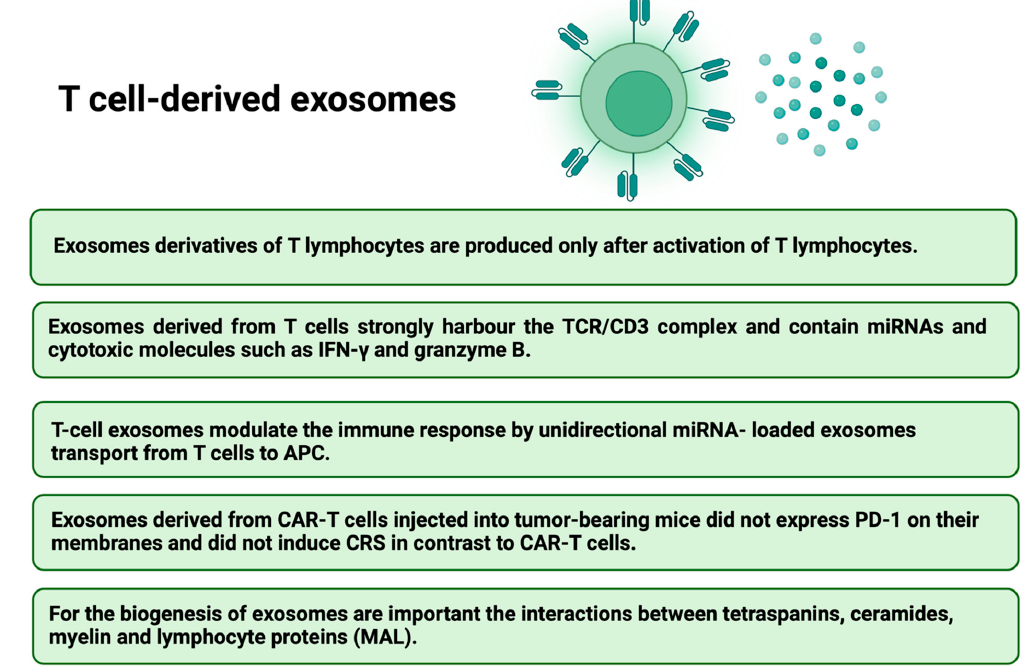
Figure 7. The features of T-cell derived exosomes [142–146].